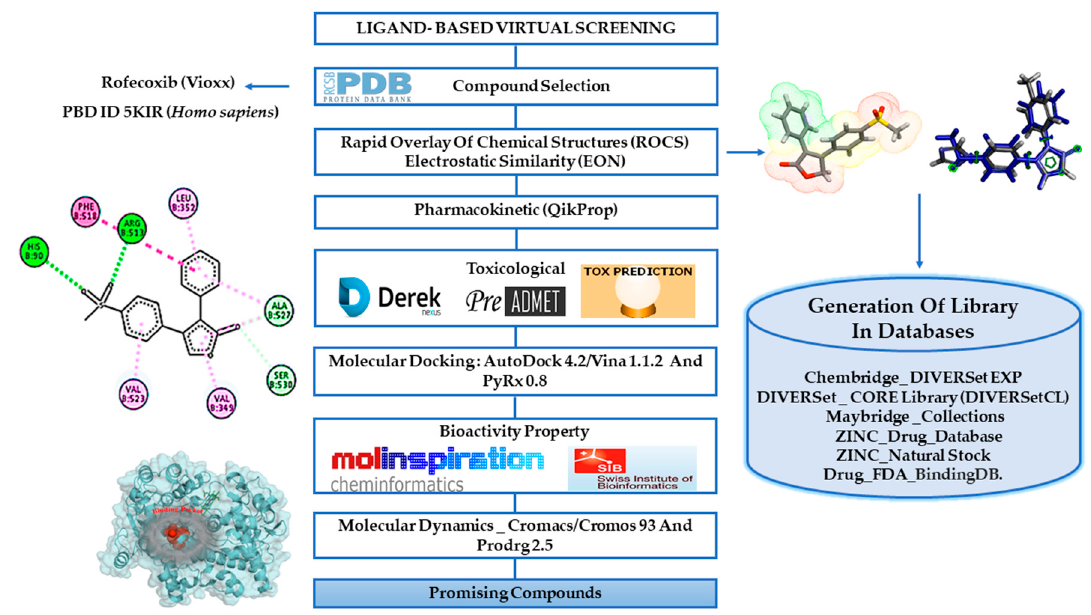
Figure 2. Workflow summarizing the methodological steps.